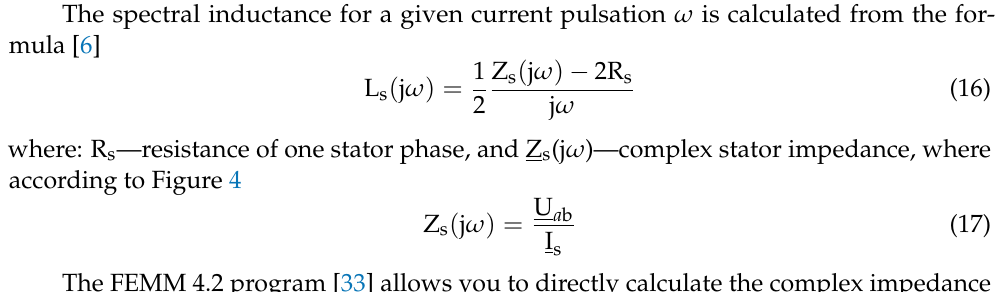
Figure 5. Distribution of the magnetic field produced by the armature current. For the frequency of 1.0 Hz, the skin effect is visible in the solid rotor.